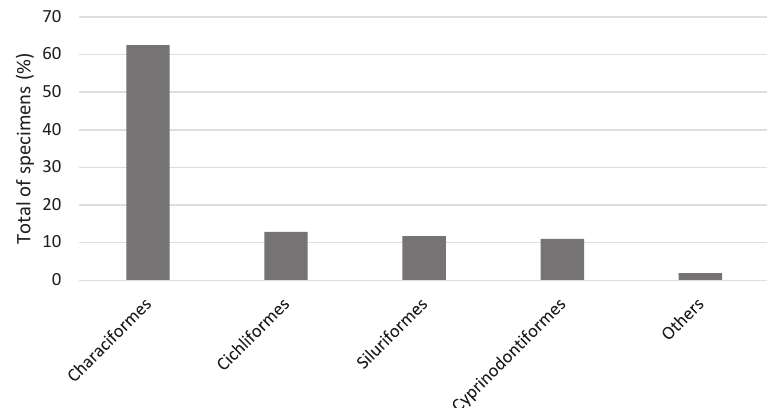
Figure 3. Percentages of the total number of specimens in each order.